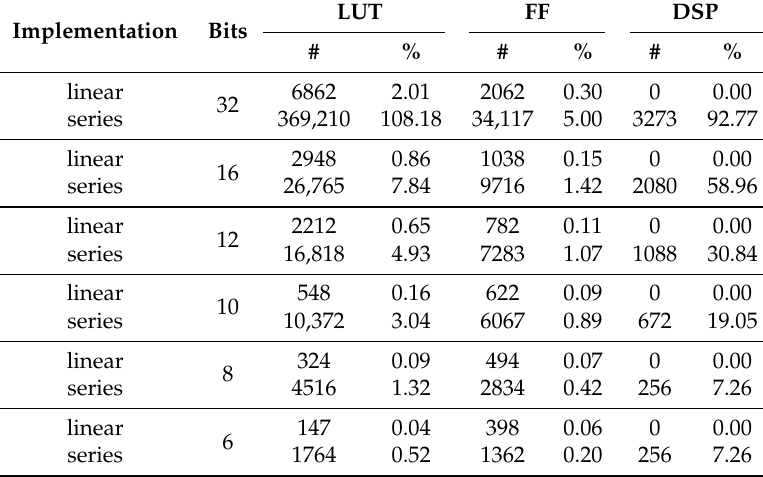
Figure A3. Tanh error as function of x . Polynomial degree is indicated with different colors. Table A1. Resources consumption for various tanh ( x ) approximation